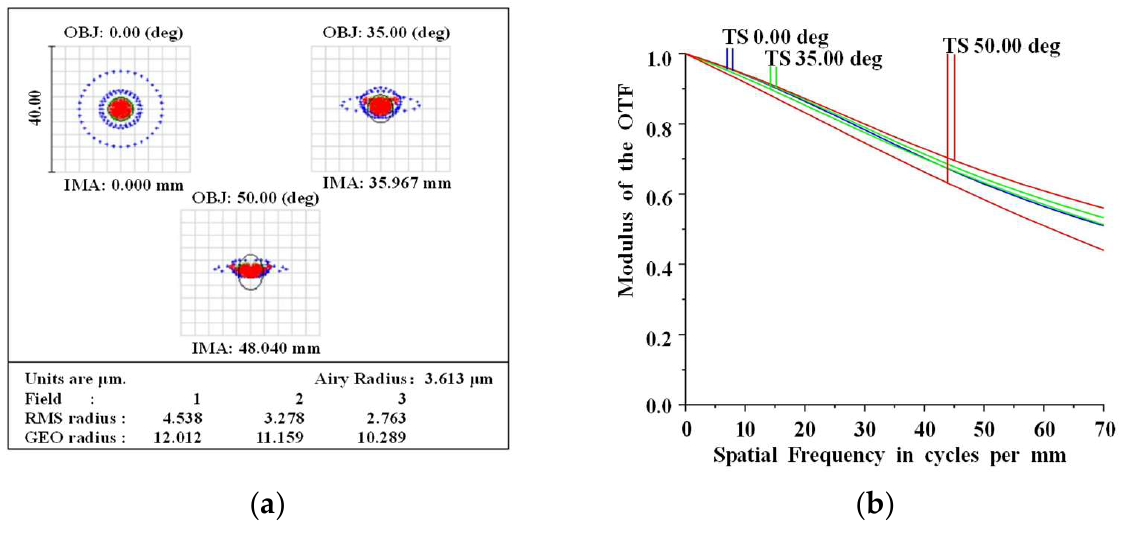
Figure 7. Imaging performance of the monocentric lens for 3000 m. ( a ) MTF curve, ( b ) Spot diagram. The pixel pitch of the curved sensor is 7 μm. The formula N = 1000/(2a) was used to